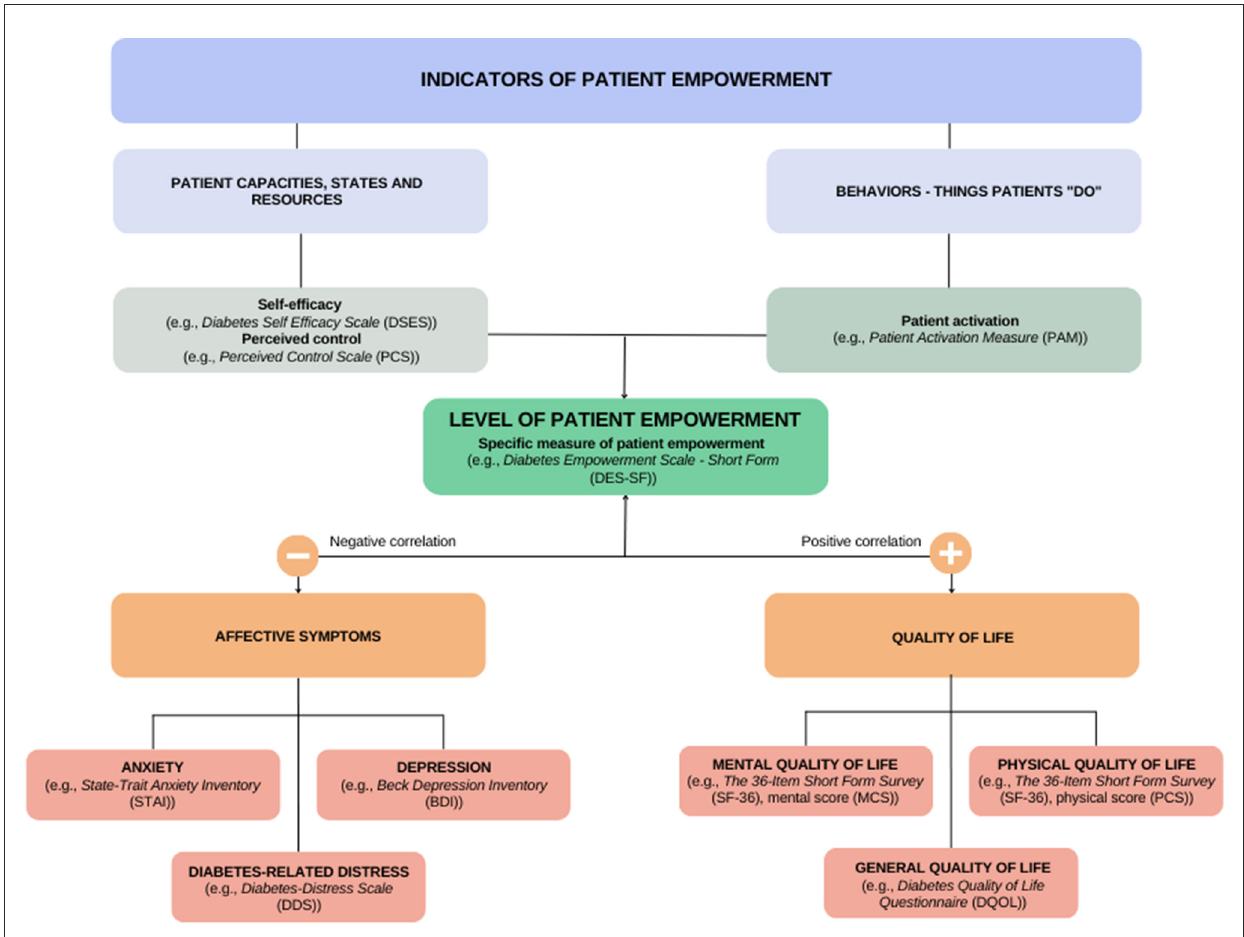
FIGURE1 Diagram of patient empowerment and related-constructs in relation to affective symptoms and quality of life. Adapted with permission from Bravo et al. (29), licensed under CC BY 4.0.